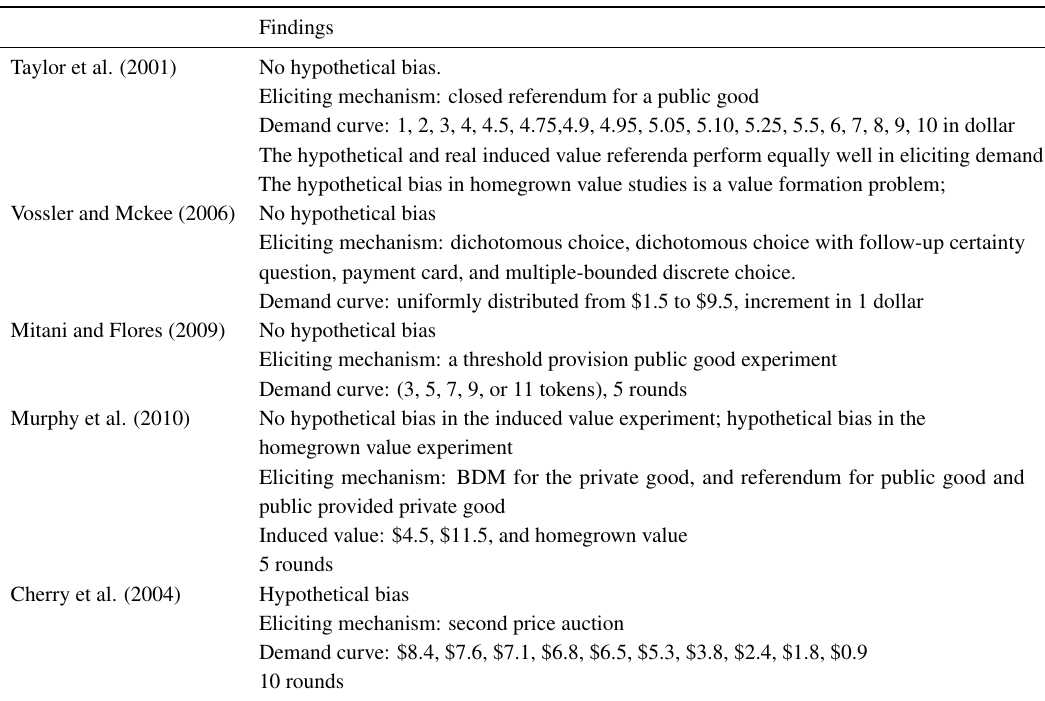
Table 6: Hypothetical bias and induced value